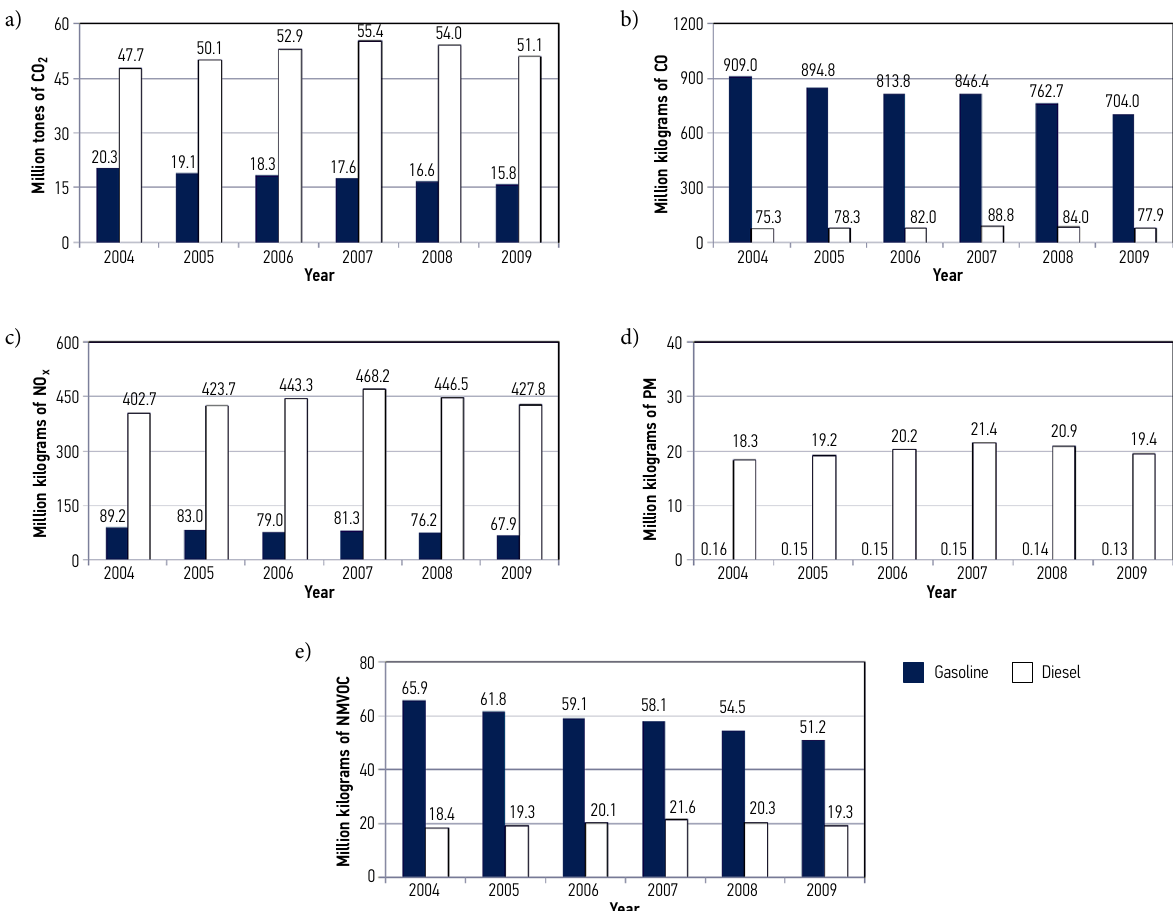
Fig. 4. Estimates of CO 2 and pollutant emissions from the Spanish interurban road transport by fuel type,